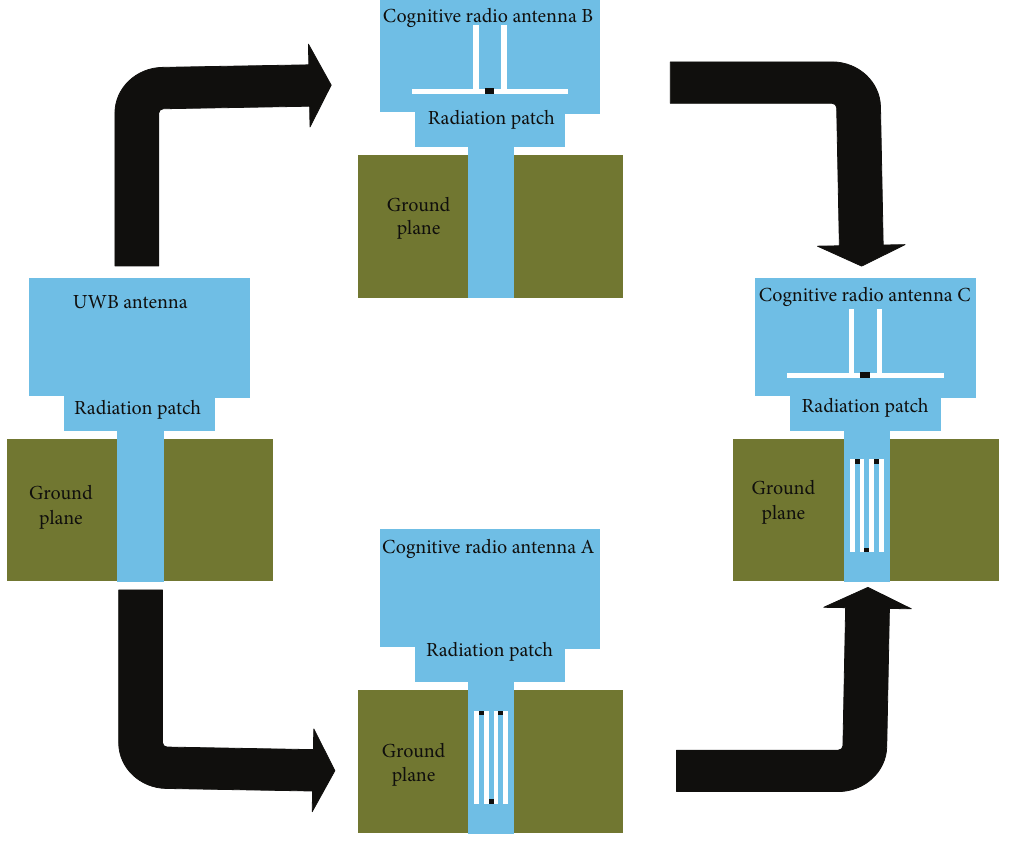
Figure 10: Design procedure of CRA